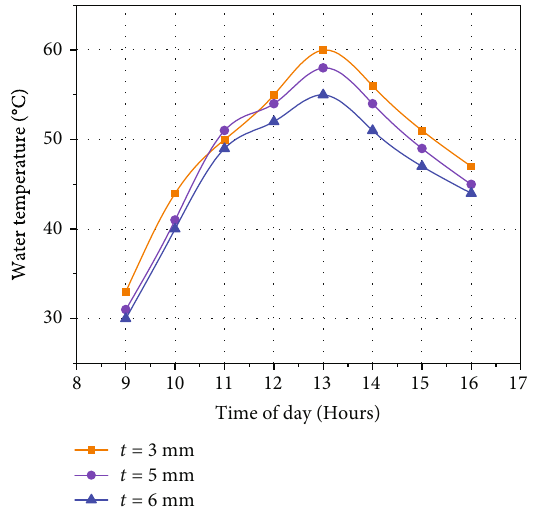
Figure 4: Time-wise fl uctuation of T